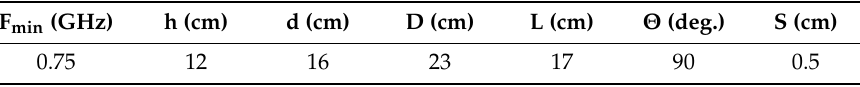
Table 1. The Proposed Discone Antenna’s